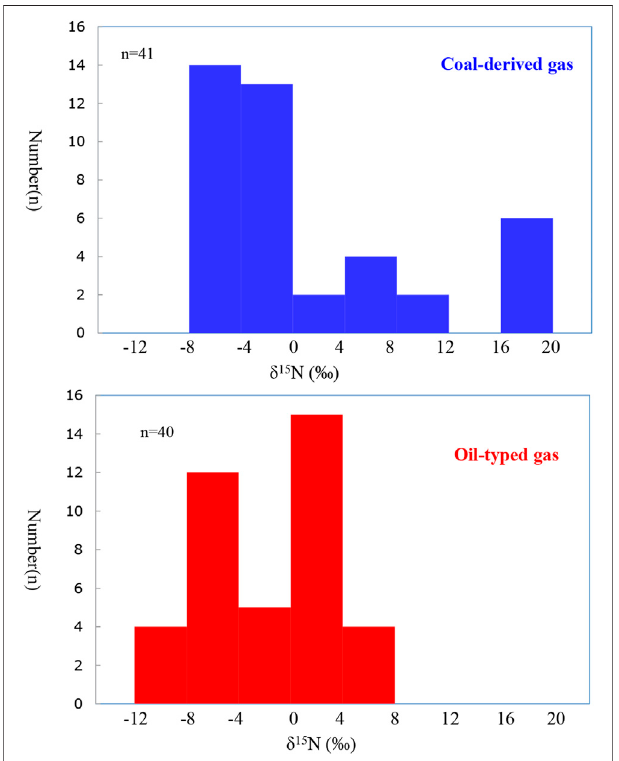
FIGURE 4 | Nitrogen isotope distributions of coal-derived gas and oil- typed gas in China.